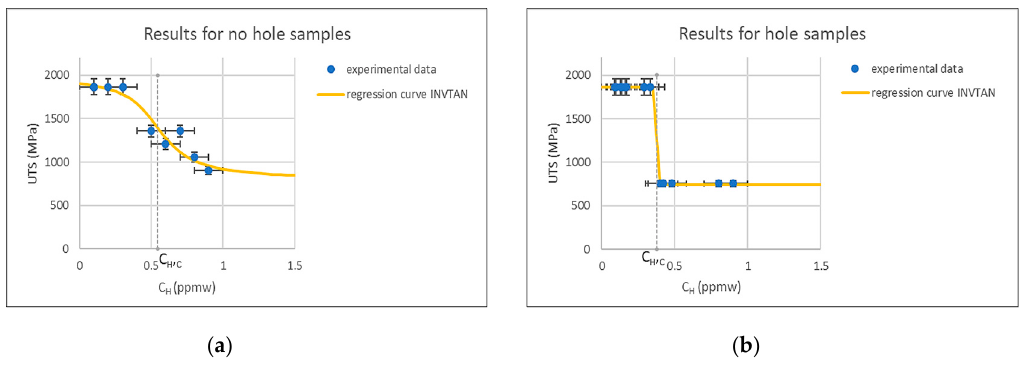
Figure 9. ( a ) USIBOR 2000 ® samples without a hole. ( b ) USIBOR 2000 ® samples with a hole.